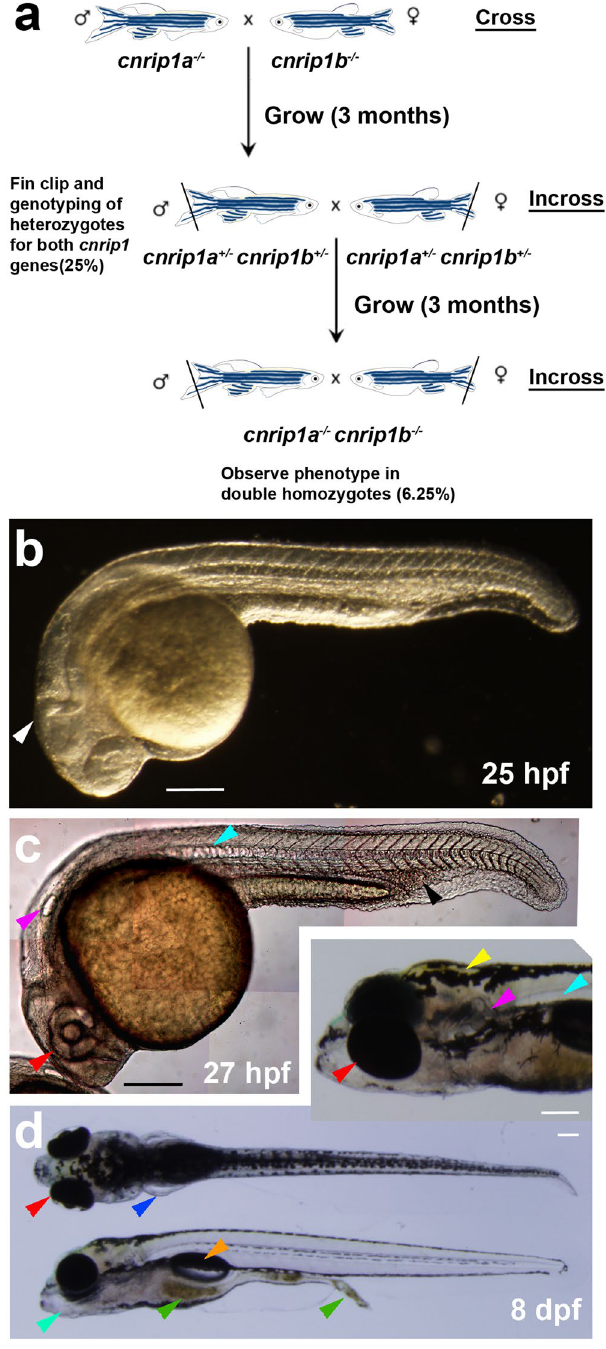
Figure 4. Maternal zygotic double cnrip1a kg98 ;cnrip1b kg101 mutant fish develop normally. ( a ) Schematic of crosses to generate a cnrip1 double mutant. ( b ) Darkfield image of 1 dpf double mutant indicating normal complex CNS folds (white arrowhead). ( c ) Differential interference contrast image of 1 dpf double mutant with arrowheads indicating normal eye (red), ear (purple), notochord (cyan) and haematopoetic tissue (black). ( d ) Dorsal, lateral and oblique (inset) views of 8 dpf larvae with arrowheads indicating pectoral fins (blue), jaw (turquoise), food traversing gut (green), swim bladder (orange) and xanthophores (yellow). Quantitative evidence of reproducibility is given in Table S1. All fish shown with anterior to left and dorsal up. Bars = 200 μ